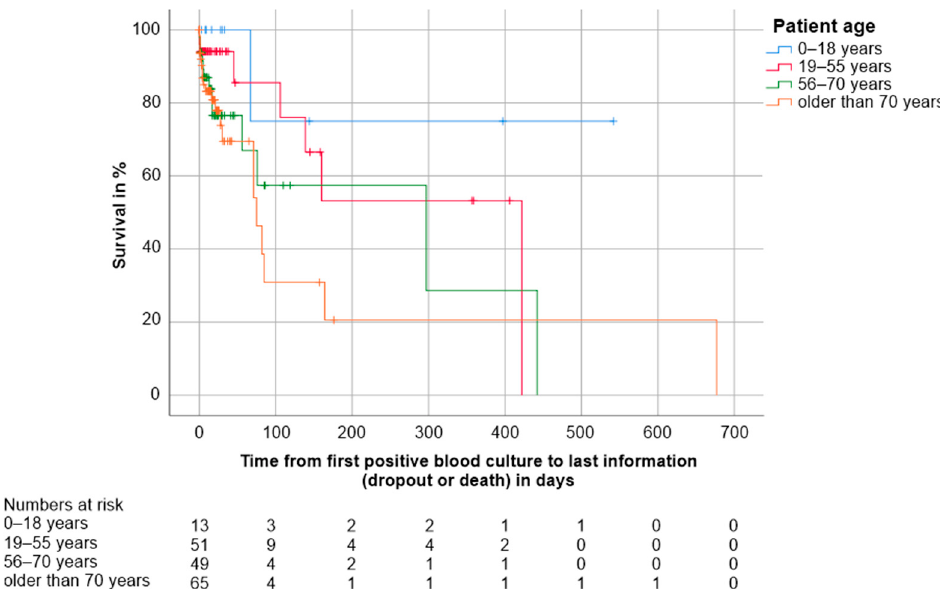
Figure 3. Kaplan Meier survival estimates for the four age groups 0–18 years ( n = 13, 1 death), 19–55 years ( n = 51, 8 deaths), 56–70 years ( n = 49, 13 deaths) and older than 70 years ( n = 65, 21 deaths). The numbers of patients under observation per age group at each time point are given below the figure. Survival was worse in patients over 70 years compared to those aged 0–18 years ( p = 0.041) and 19–55 years ( p = 0.023). Data of three patients were missing.